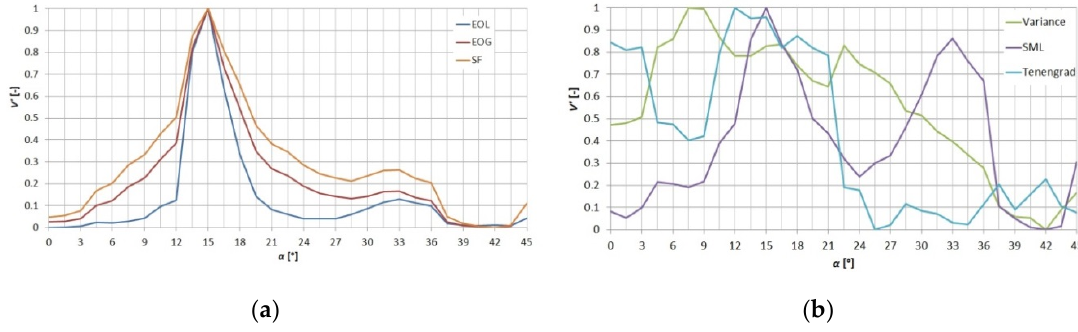
Figure 3. Relationship V’ = f( α = const) for the third series of thermograms: ( a ) sharpness measures: energy of Laplacian (EOL), spatial frequency (SF), energy of gradient (EOG); ( b ) sharpness measures: variance, sum modified Laplacian (SML), Tenengrad.